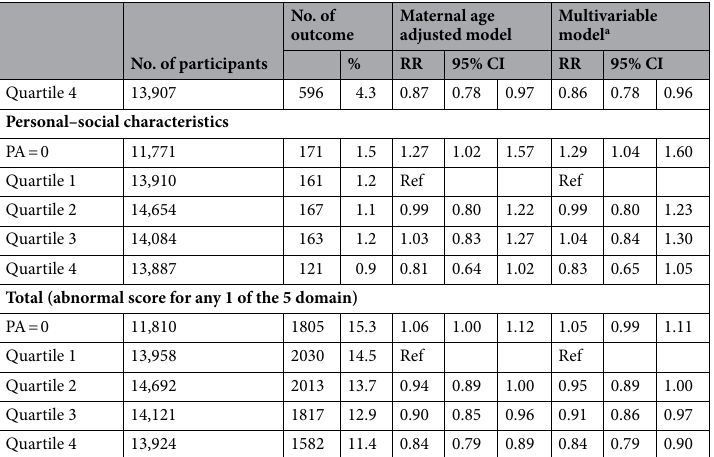
Table 2. Association between physical activity before pregnancy and infant sleep and development, Japan Environment and Children’s Study (2011–2014). PA physical activity, CI confidence interval, RR risk ratio, Ref reference. a Adjusted for maternal age at delivery, smoking habits, alcohol consumption, pre-pregnancy body mass index, gestational age at birth, parity, infertility treatment, infant sex, type of delivery, psychological distress at 1 year after delivery, diagnosis of asthma and atopic dermatitis at 1-year-old, and feeding